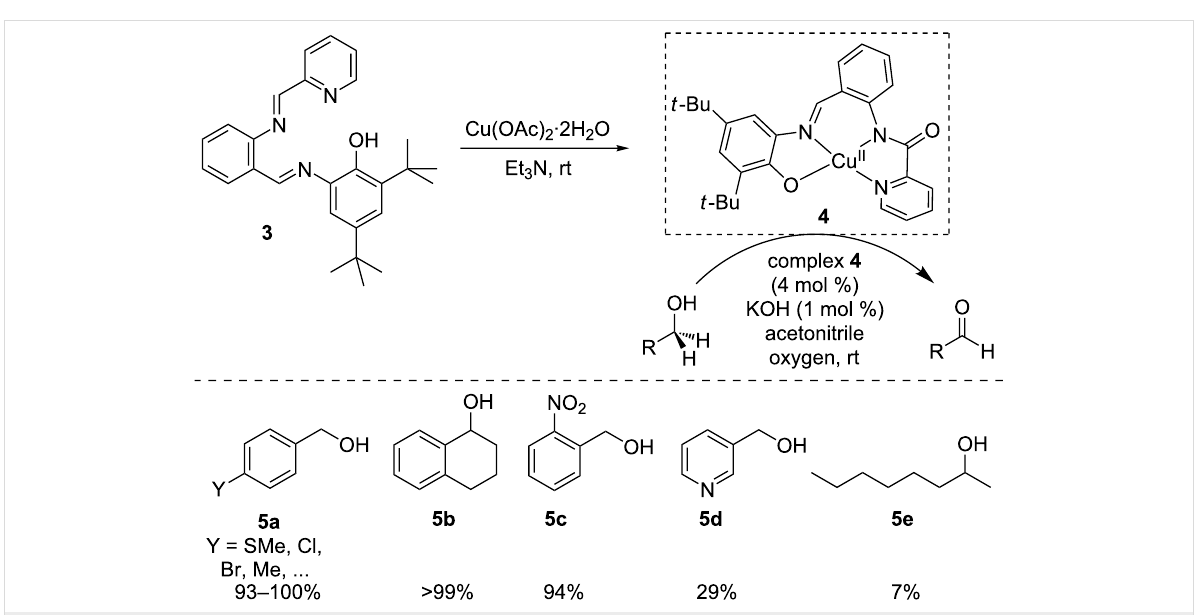
Scheme 2: Copper-catalyzed aerobic oxidation of alcohols and representative substrate